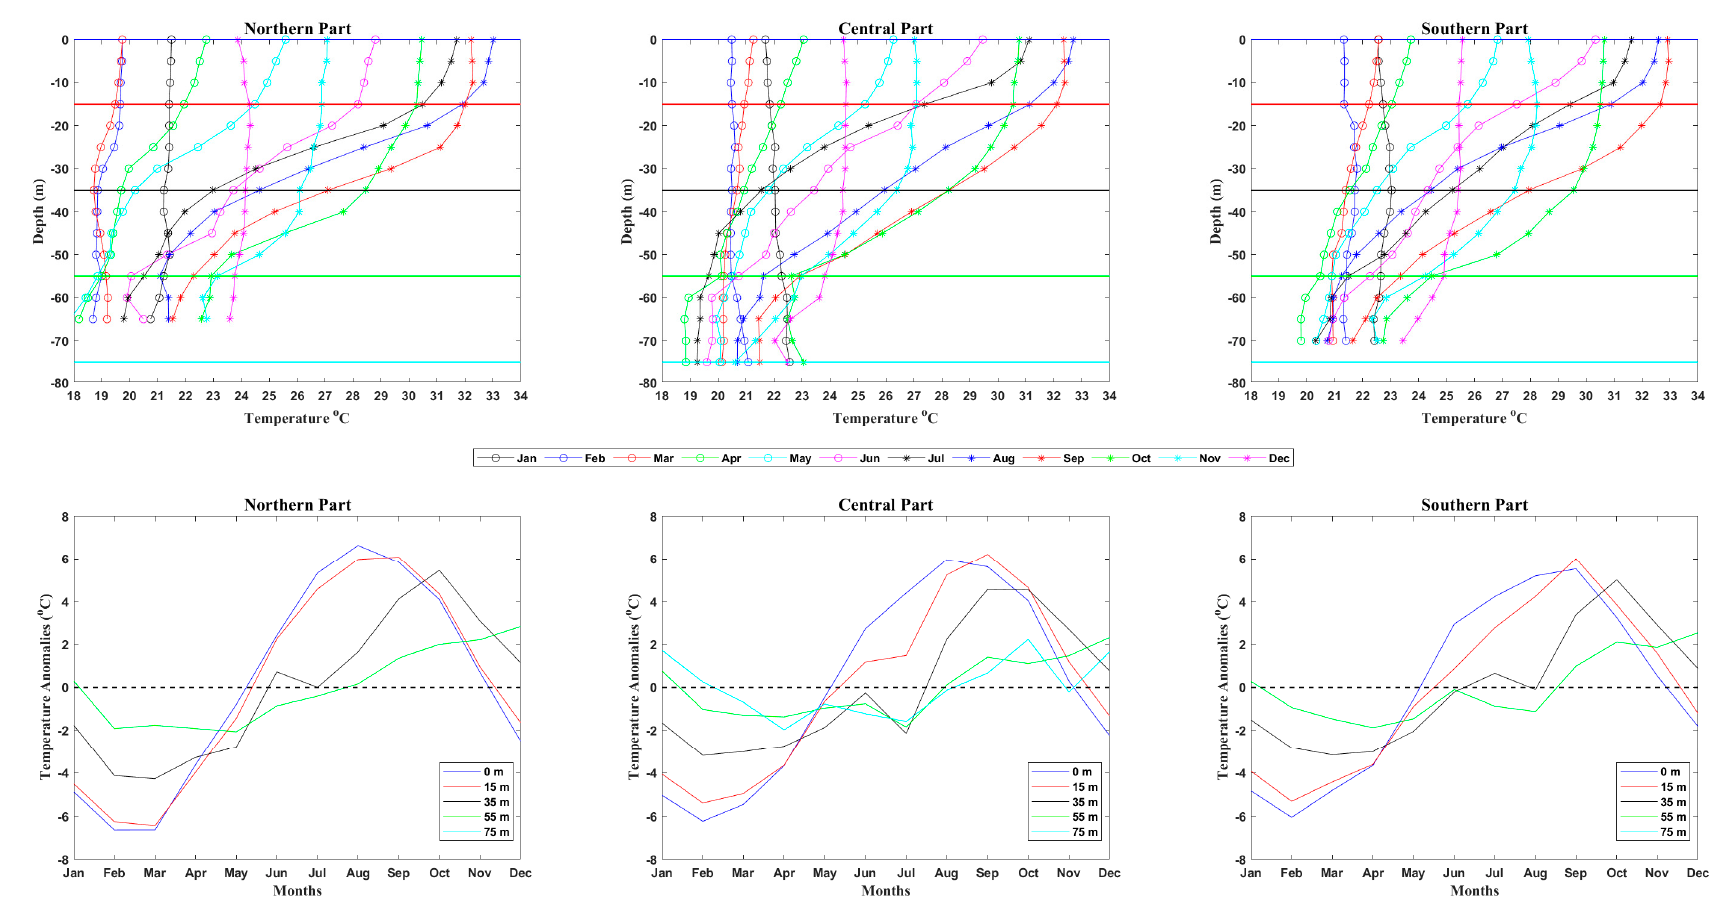
Figure 2. ( Upper panel ): monthly temperature profiles at north ( left ), center ( middle ), and south ( right ) of AG. The ( lower panel ): temperature anomalies at selected depths marked with different color in the upper panel. For profile and location, refer to Figure 1.